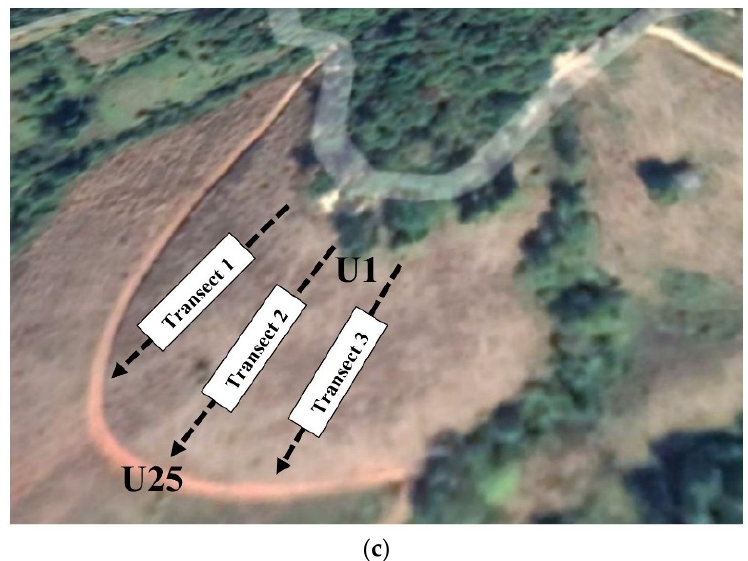
Figure 1. Study area. ( a ) Overall study area, ( b ) terraced paddy field and ( c ) upland rice. The aerial images were taken from Google maps on 25 February 2020. The photos were taken on 14 November 2020 by Noppol